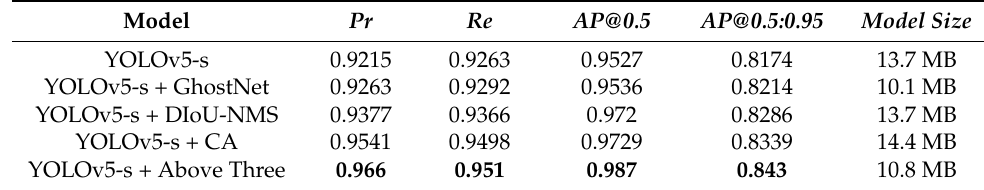
Table 4. YOLOv5 ablation